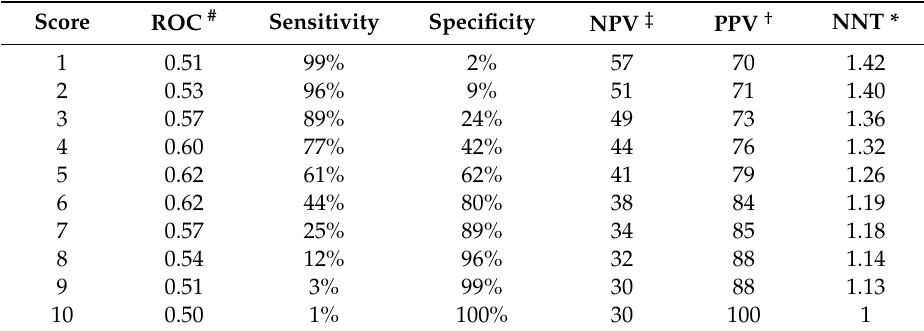
Figure 1. A risk-model using clinical variables to predict low Se. ( A ) Point distribution and cutoffs based on the unsupervised discretization. ( B ) Logistic regression of the risk-model with low selenium concentrations (<100 µg/L) as the outcome variable. Score 0 was the reference score. Table 2. Statistical measures of all scores.